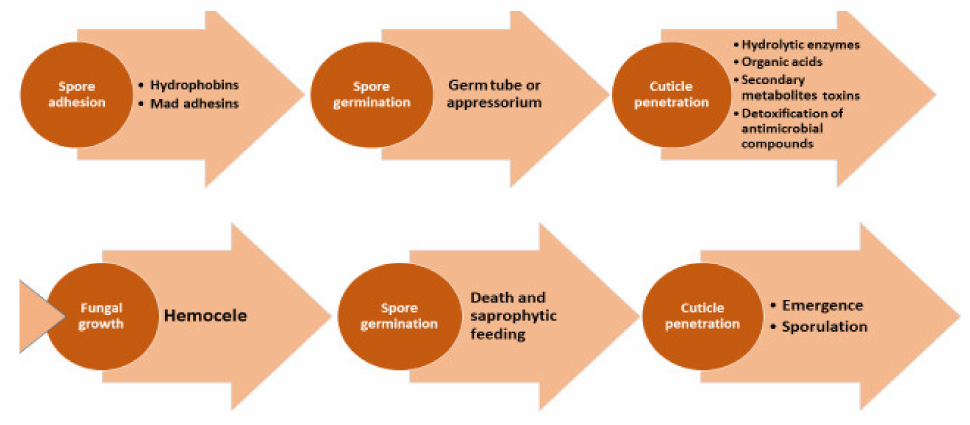
Figure 3. Hirsutella thompsonii mode of